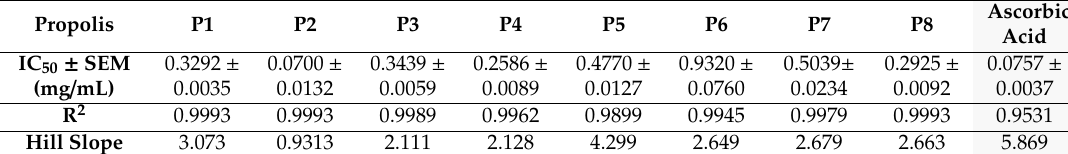
Table 3. The IC 50 value of propolis samples vs. ascorbic acid (best-fit values *).